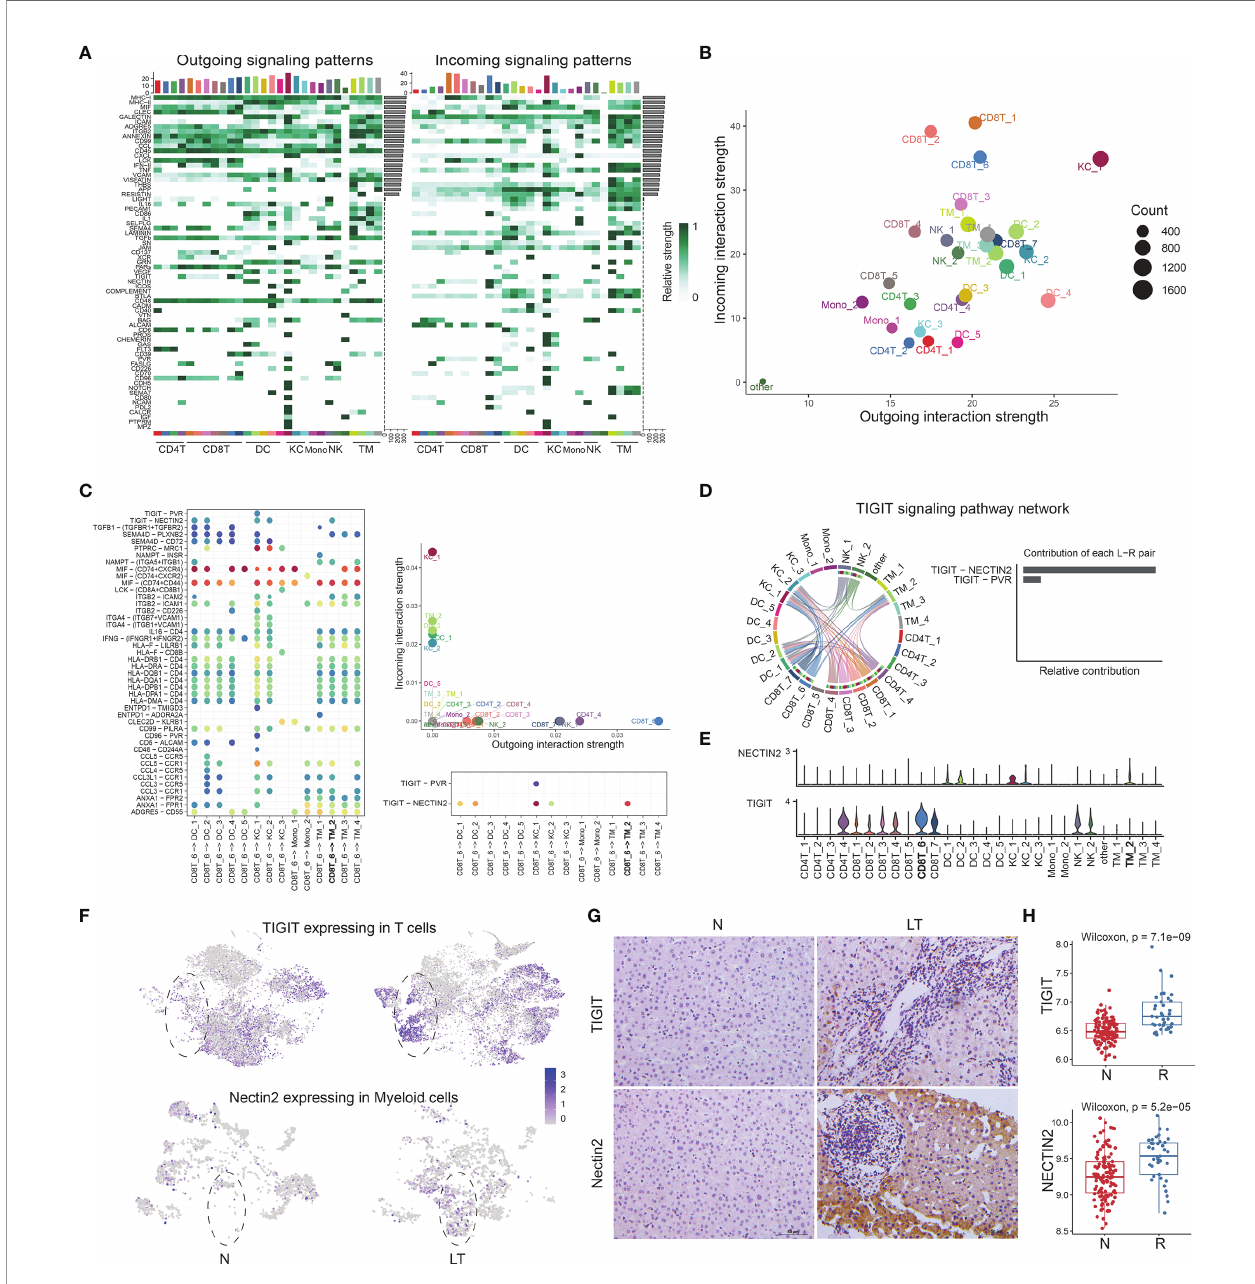
FIGURE 7 | The multi-lineage interactome in the liver tissue. (A) Overview of outgoing and incoming signaling patterns among T, NK, and myeloid cell groups in liver transplantation tissue. (B) Projecting signaling pathways with bubble plots. Each dot represents the communication network of one signaling pathway. Dot size is proportional to the overall communication probability. (C) Dotplots showing the interactions between exhausted CD8+ T cells and myeloid cells in liver transplantation. (D) The distribution and contribution of TIGIT signaling pathway network. (E) Expression of TIGIT and NECTIN2 among T, NK, and myeloid cells. (F) tSNE plots showing the TIGIT expression in exhausted CD8+ T cells and the NECTIN2 expression in LDLR+ macrophage cells. (G) Immunohistology of TIGIT and NECTIN2 in normal and liver transplantation tissue. (H) Bulk RNA-seq expression of TIGIT and NECTIN2 in stable (n=129) and rejection samples (n=37) after liver